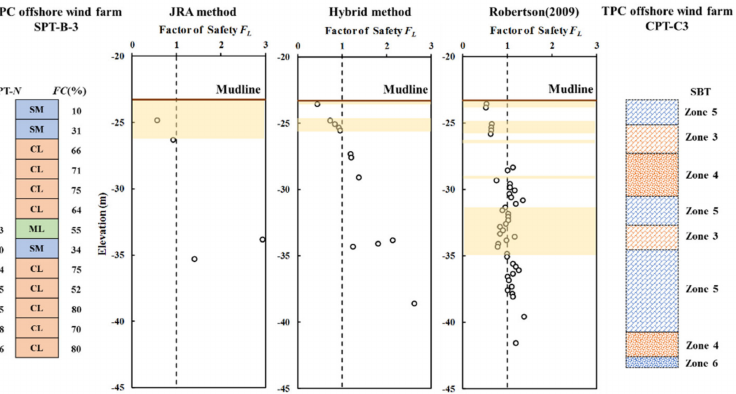
Figure 13. The soil liquefaction potential of boreholes CPT-C3 and SPT-B-3 in TPC offshore wind farm.